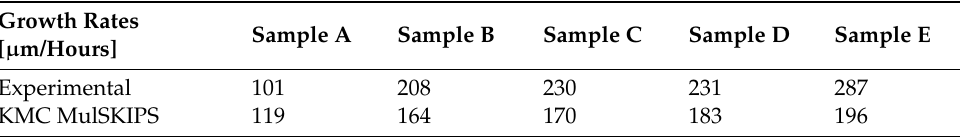
Table 1. Experimental and simulated growth rates. The samples listed here refer to the growth conditions marked with A,B,C,D,E in Figure